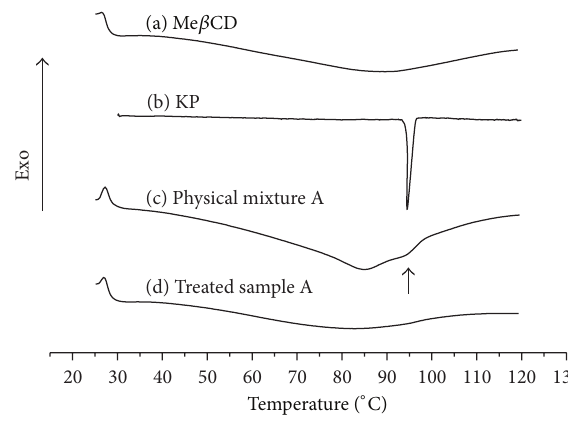
Figure 3: Typical DSC curves of the KP :Me 𝛽 CD system: (a) pure Me 𝛽 CD, (b) pure KP, (c) physical mixture A (16.3% KP), and (d) sample A (16.3% KP) treated in scCO 2 at 40 ∘ C 20 MPa